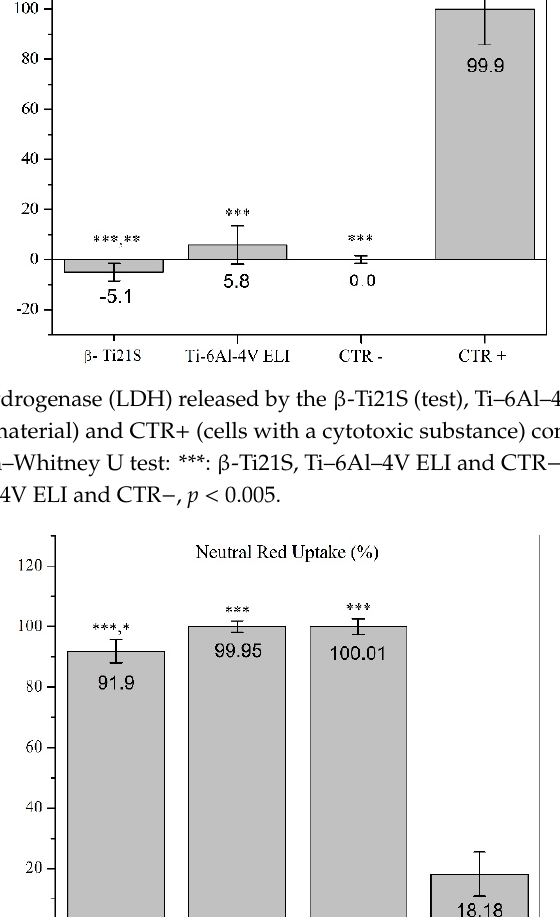
Figure 11. Neutral red uptake quantification of cells exposed to the β -Ti21S (test), Ti–6Al–4V ELI (reference), and CTR − (cells without material) and CTR+ (cells with a cytotoxic substance) controls and expressed as a percentage of CTR − . (Kruskal–Wallis followed by the Mann–Whitney U test. ***: β -Ti21S, Ti–6Al–4V ELI, and CTR − vs. CTR+, p < 0.0005. *: β -Ti21S, vs. Ti–6Al–4V ELI and CTR − , p < 0.05).